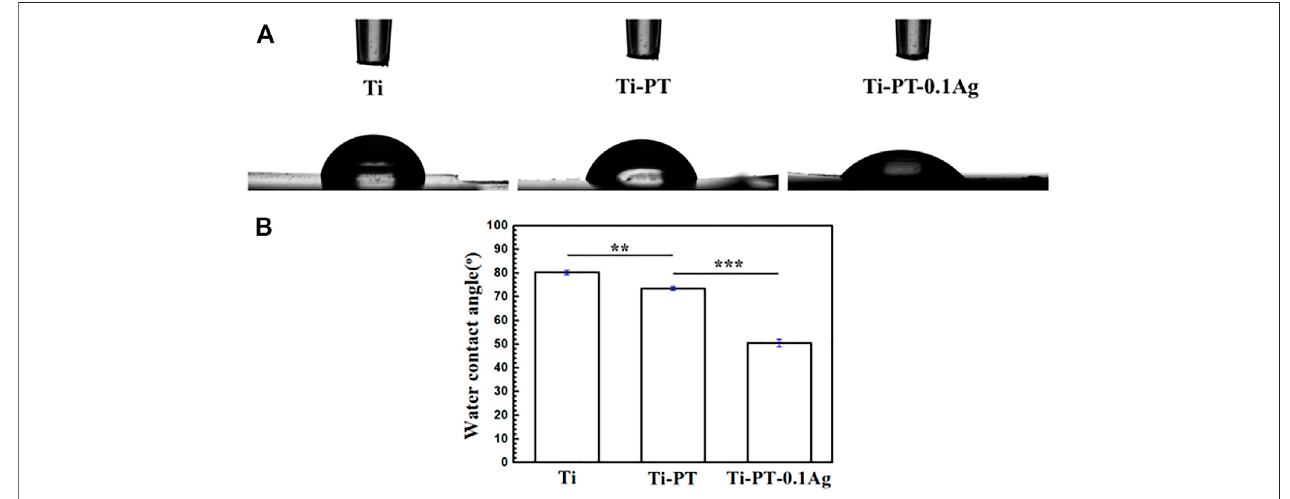
FIGURE 2 | (A) Shapes of water droplets on the Ti, Ti-PT, and Ti-PT-0.1Ag. (B) Static water contact angles of Ti, Ti-PT, and Ti-PT-0.1Ag. Data are presented as mean ± SD and analyzed by one-way ANOVA (** p < 0.01, *** p < 0.001).